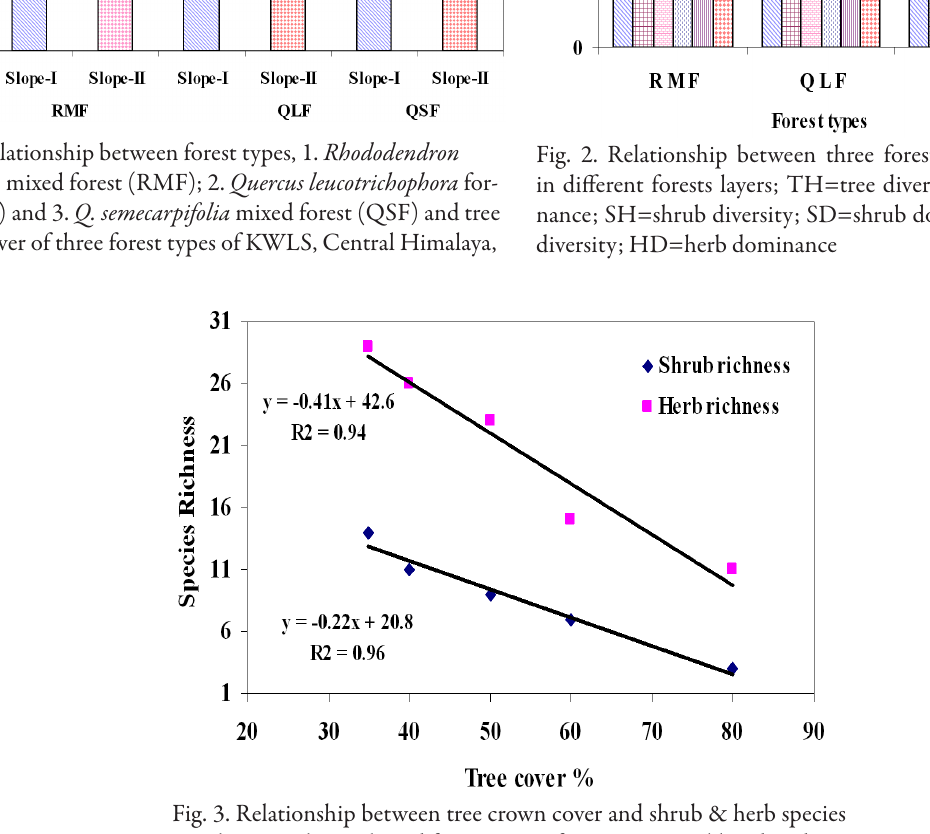
Fig. 3. Relationship between tree crown cover and shrub & herb